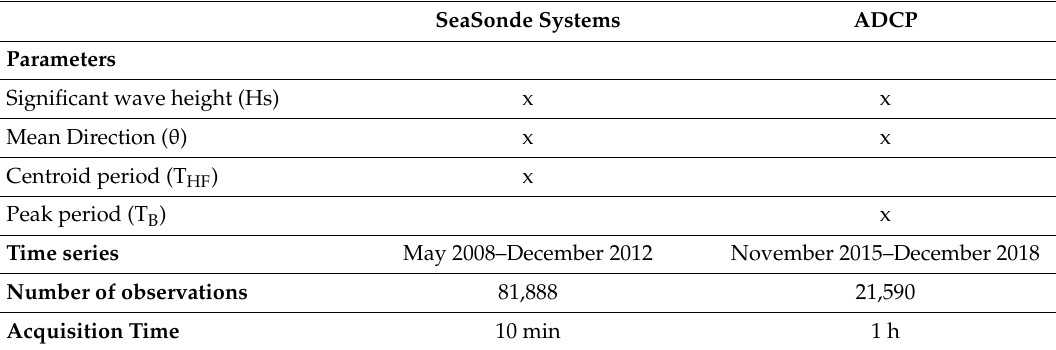
Table 1. Characteristics of the measurement systems and the